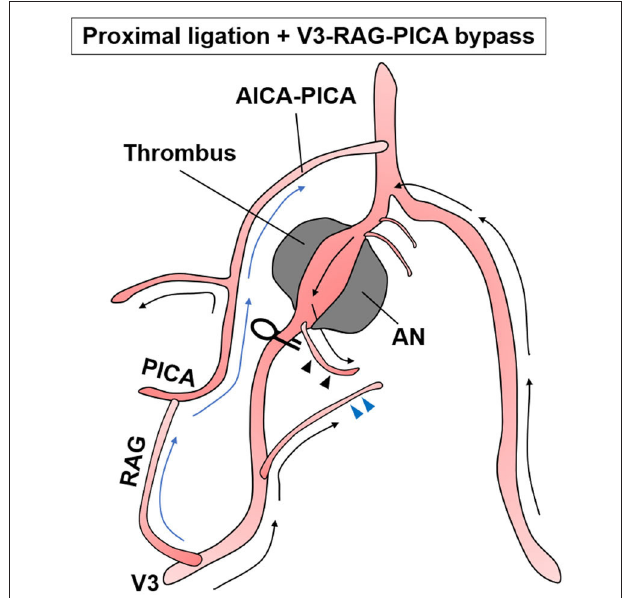
FIGURE 7 | Schematic of the treatment strategy for case 3.